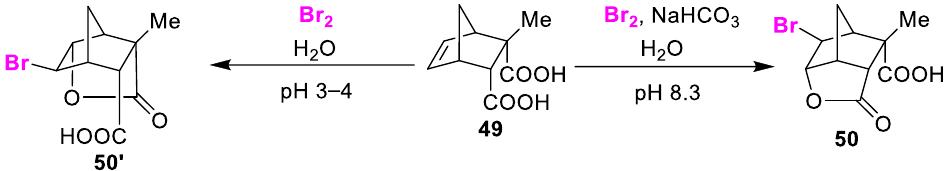
Figure 25. pH-dependent regioselective bromo-lactonization of olefinic dicarboxylic acid 49 .